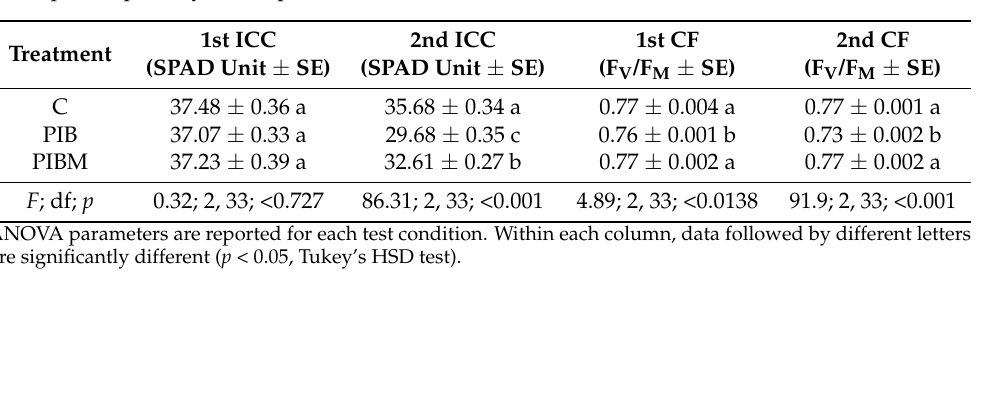
Table 1. Stress state of plants recorded during the first and second nondestructive measurements, as indicated by the calculation of the amount of chlorophyll present in the leaf (ICC) and by calculation of the plant’s photosynthetic performance